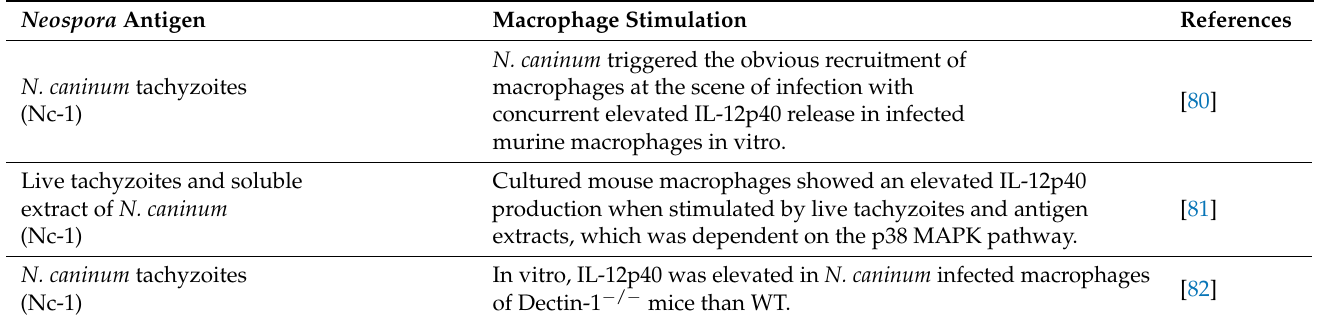
Table 2. A summary for previous studies assessed the effect of N. caninum or its derived molecules on macrophage production of